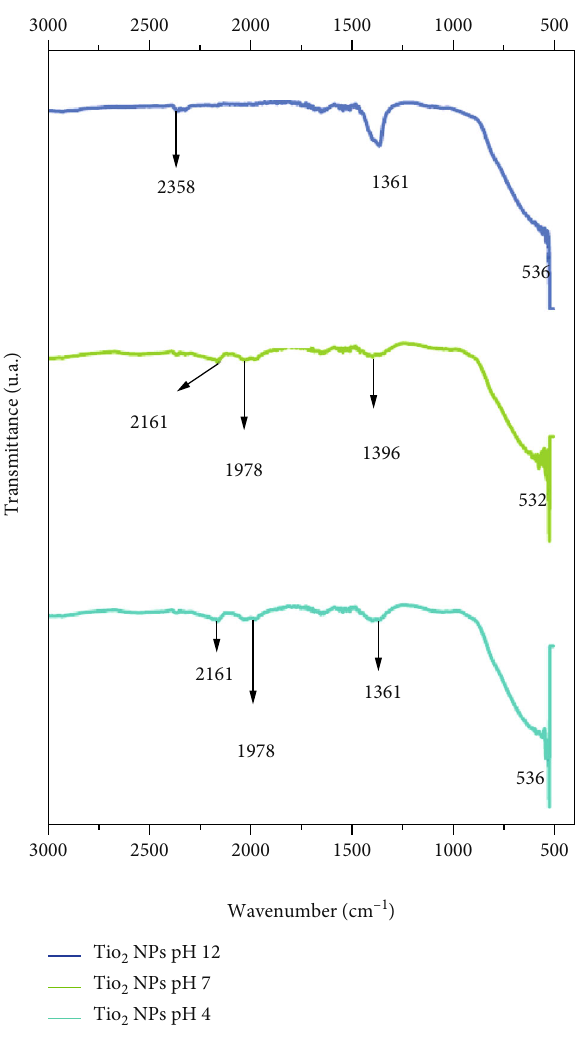
Figure 2: FT-IR spectroscopy analysis for TiO and 4, phytosynthesized with extract of E. crassipres